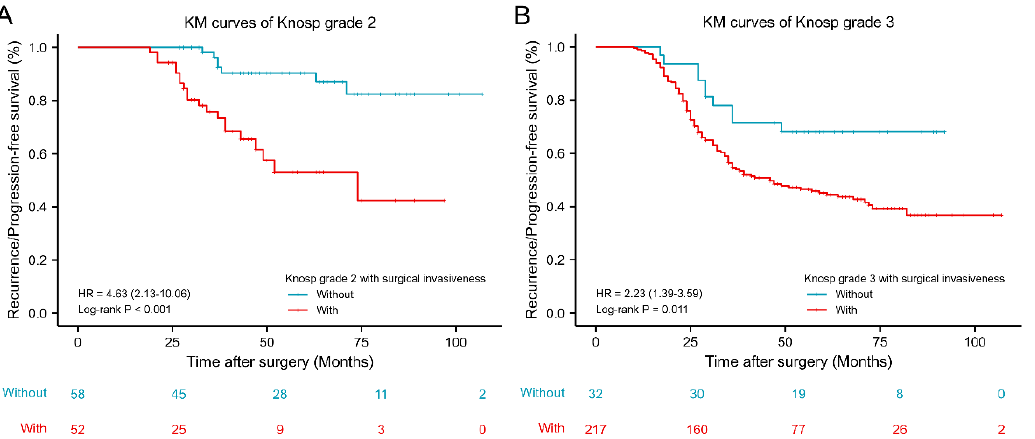
Figure 6. Kaplan–Meier survival curves of Knosp grade 2–3 with or without surgical invasiveness. ( A ) Kaplan–Meier survival curves of Knosp grade 2 with or without surgical invasiveness. ( B ) Kaplan–Meier survival curves of Knosp grade 3 with or without surgical invasiveness. KM: Kaplan–Meier; HR, Hazard Ratio.